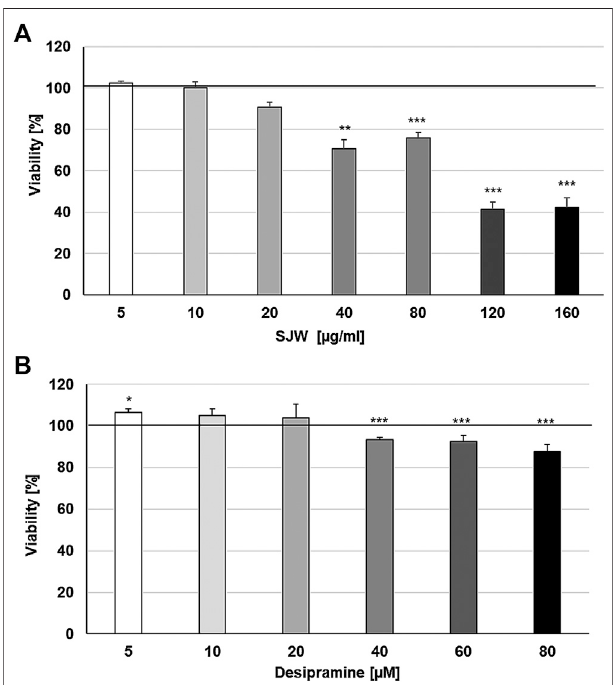
FIGURE 1 | Effects of 48 h treatment with (A) STW3-VI [St. John ’ s wort (SJW)] extract or (B) desipramine on the viability of mouse SIM-A9 microglia. Viability was measured by PrestoBlue ® assay. Values [in % viability of untreated control (control (cid:2) 100% viability)] are given as mean + SEM; signi fi cance (by T-TEST): ** p ≤ 0.01 or *** p ≤ 0.001 vs. untreated control; n (cid:2) 4.